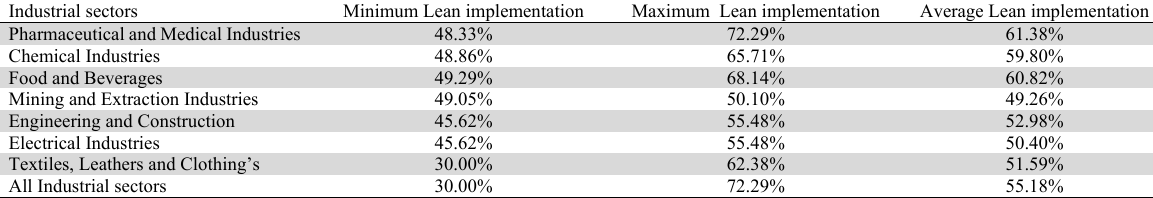
Descriptive statistics for lean manufacturing implementation to each sector Industrial sectors